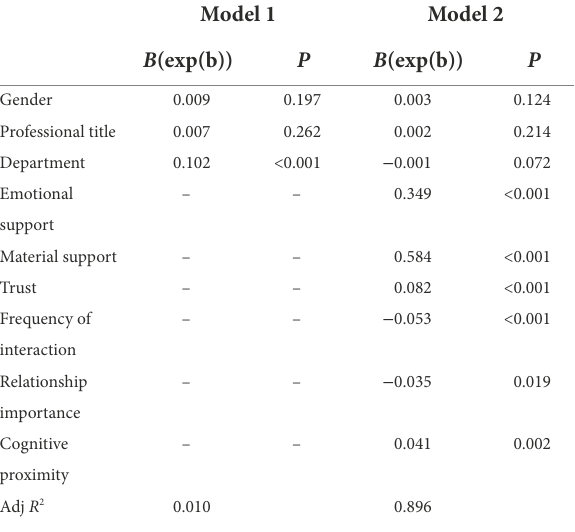
TABLE 3 Result of QAP multiple